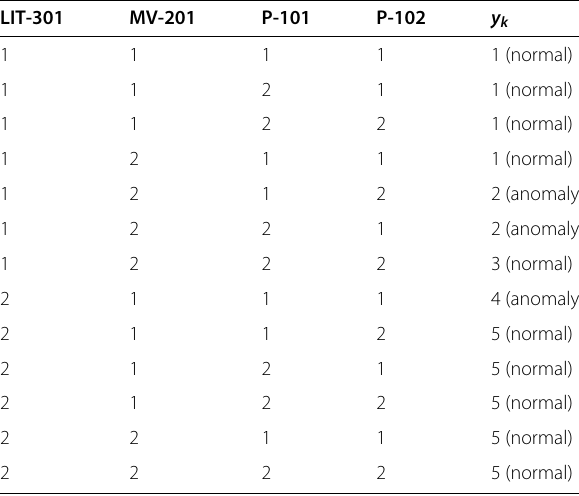
Table 9 Training set of Invariant #3 for SWaT